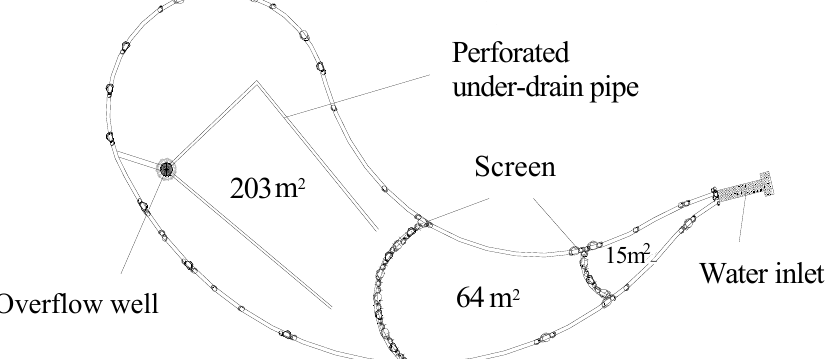
Figure 3. Plane layout of the rain garden.